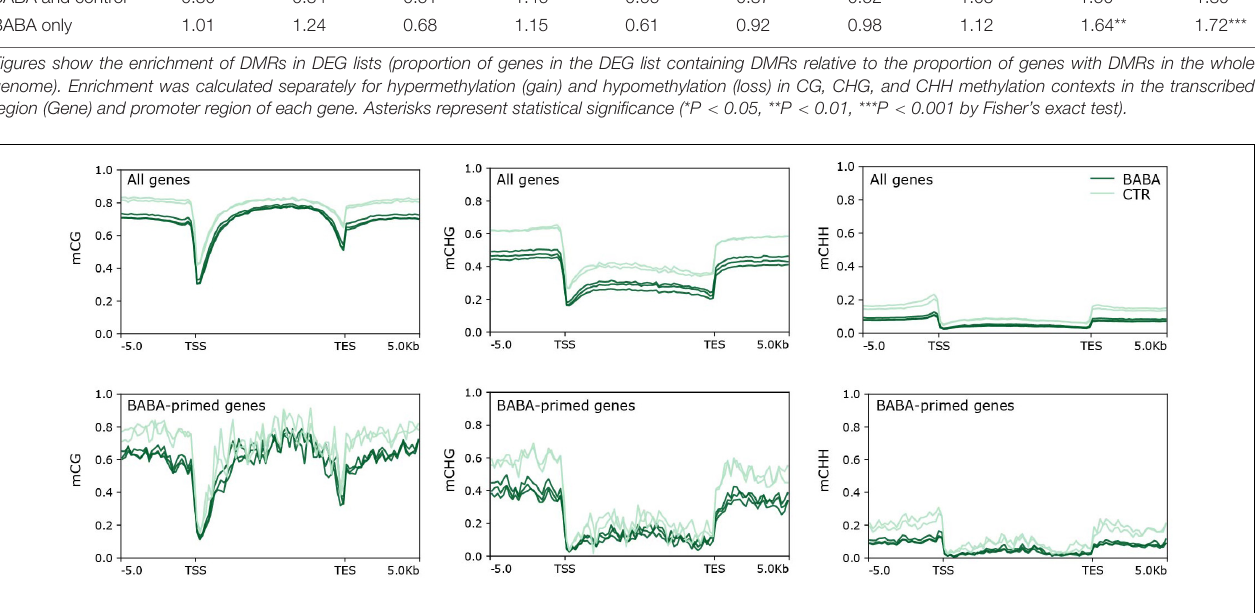
TABLE 2 | Representation of DMRs amongst the three main categories of DEGs. CG Gain CG Loss CHG Gain CHG Loss CHH Loss Gene Promoter Gene Promoter Gene Promoter Gene Promoter Gene Promoter Control only 0.45